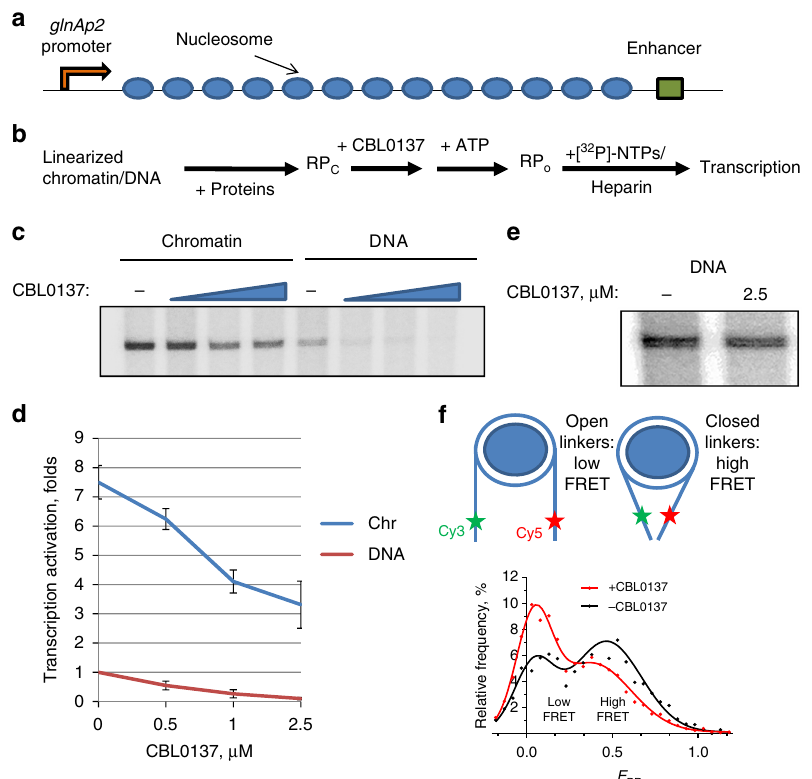
Fig. 2 CBL0137 inhibits EPC in vitro. a A 13-nucleosome 601 207×13 array for EPC rate analysis 30, 33 . b Experimental approach for the EPC rate analysis on DNA and chromatin 30 . After assembly of the corresponding DNA – protein complexes at the promoter and enhancer, the array was incubated with CBL0137, and EPC was initiated. The addition of labeled rNTPs with heparin allows transcript synthesis, prevents a second round of transcription, and eliminates the nucleosomal barrier for the transcribing RNA polymerase. c Transcription of the array in the presence of increasing CBL0137 concentrations (0.5, 1, and 2.5 µ M). Analysis of labeled transcripts by denaturing PAGE. d Quantitative analysis of the 176-nt transcripts shown in c . Error bars represent the s.d. based on four independent measurements using two different reconstitutes. e Transcription of the DNA array having a short distance (708 bp) between the enhancer and promoter in the presence or absence of CBL0137. f CBL0137 affects the conformation of linker nucleosomal DNA. Top: Fluorescently labeled nucleosomes (asterisks mark positions of Cy3 and Cy5 labels) having 40-bp extending DNA linkers were incubated with or without CBL0137 (0.5 µ M). Bottom: Typical frequency distributions of nucleosomes by proximity ratio ( E PR ) measured using spFRET microscopy. Experimental data (dots) were fi tted with a sum of two Gaussians (solid lines). The sample sizes ( n , single particle events) were: ( + CBL0137) – 4310; ( − CBL0137) – 2832. The mean values of E PR peak maxima and s.e.m. averaged over three independent experiments were: ( + CBL0137) – 0.04 ± 0.01, 0.38 ± 0.04; ( − CBL0137) – 0.04 ± 0.02, 0.47 ± 0.04. Source data of Fig. 2c – f are provided in a Source Data fi